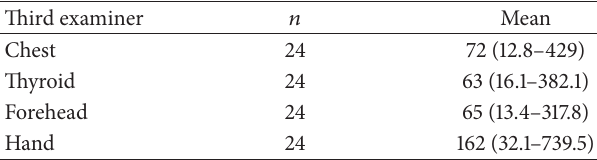
Table 6: Third staff (trainee) mean radiation doses ( 𝜇 Gy) for group B per ERCP procedure. The range is in